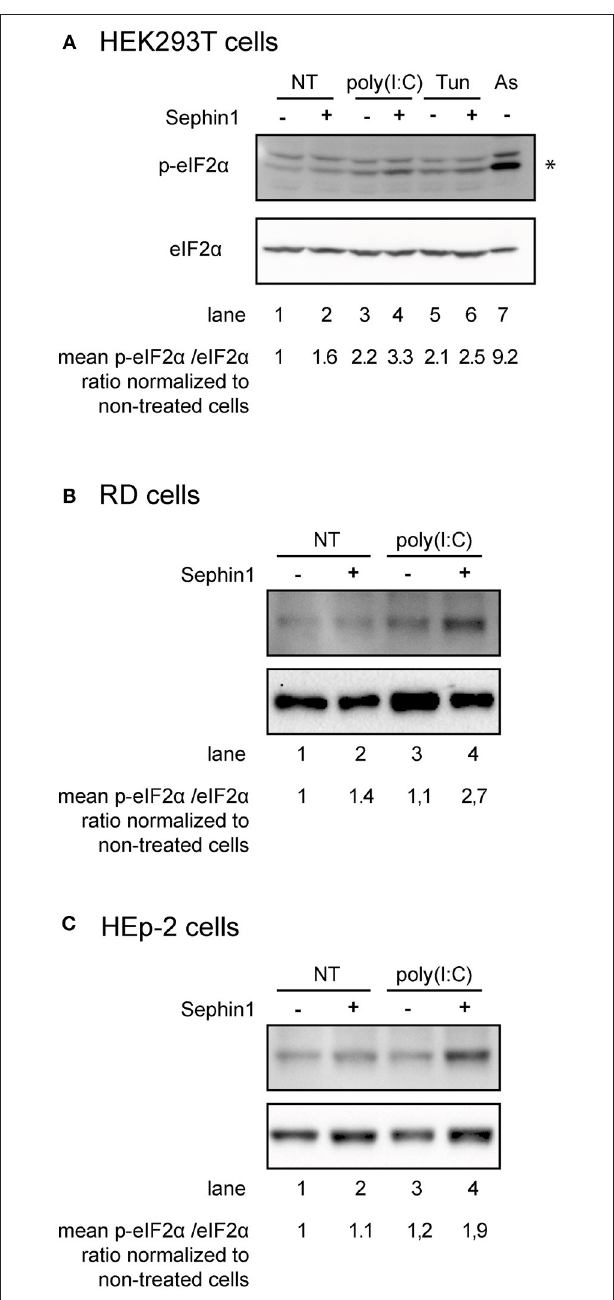
FIGURE 1 | Consequences of Sephin1 treatment on eIF2 α phosphorylation. (A) HEK293T cells were either left untreated (NT), treated for 16h with intracellularly delivered poly(I:C), which stimulates PKR or with tunicamycin (Tun), which stimulates PERK, in the presence or absence of 50 µ M Sephin1. The asterisk indicates the position of phosphorylated eIF2 α , as revealed in cells stimulated with sodium arsenite (As), a potent inducer of eIF2 α phosphorylation. (B) RD cells and (C) HEp-2 cells were either left untreated (NT) or treated for 16h with intracellularly delivered poly(I:C), in the presence or absence of 50 µ M Sephin1. The mean fold increase of the phosphorylated eIF2 α phosphorylation/total eIF2 α ratio normalized to non-treated cells calculated from three independent experiments is shown below the